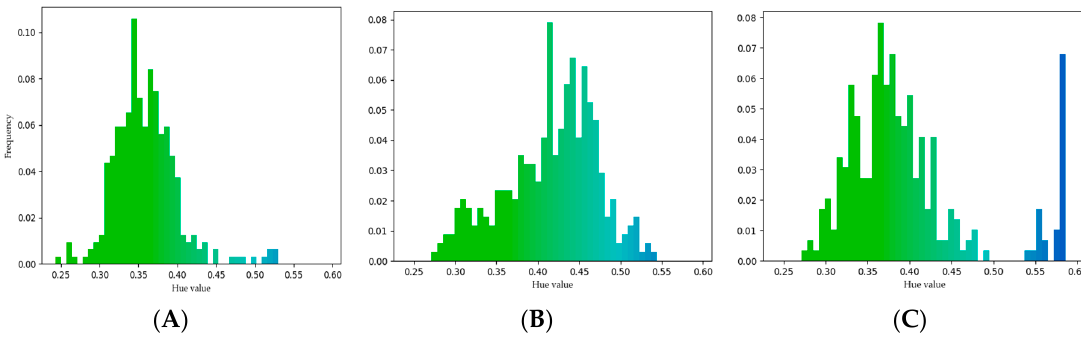
Figure 3. Fluorescence colour dispersion chart of digital images of Alnus glutinosa pollen experimental variant groups by hue values: ( A )—control (C_1); ( B )—three-hour exposure (3 h_1); ( C )—five-hour exposure (5 h_1). The x-axis represents hue values and the y-axis represents the number of cases.